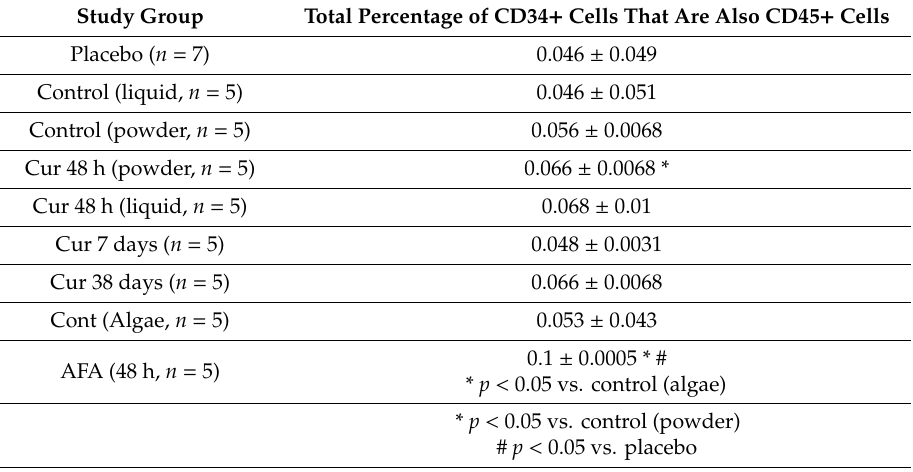
Table 2. Total percentage of CD34 + cells that are also CD45 + in healthy